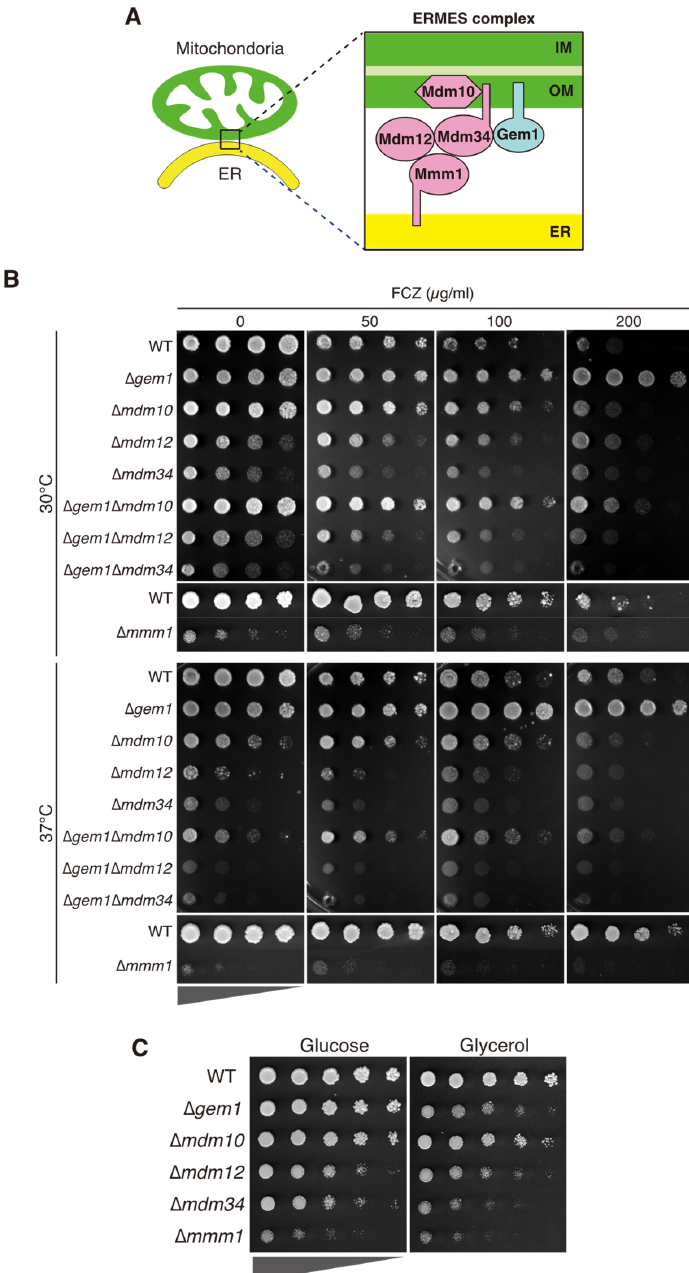
Figure 1. Resistance to azoles by deletion of GEM1 . ( A ) Schematic diagram of the ERMES complex, based on a report in S . cerevisiae . OM, outer membrane. IM, inner membrane. ( B ) Growth of strains lacking ERMES components ( ∆ mdm12 , ∆ mdm3 4, ∆ mdm10 , ∆ mmm1 , and ∆ gem1 ) in the presence or absence of fluconazole. The cells were diluted to OD 600 (optical density at 600 nm) of 0.5 in water and spotted in 4 ‐ fold serial dilutions (indicated by triangles) on agar plates of minimal SD medium containing the indicated concentration of fluconazole. All cells except for ∆ mmm1 cells were incubated for 2 days (upper panel), and ∆ mmm1 cells were incubated for 3 days at 30 °C or 37 °C. ( C ) Growth of strains lacking ERMES components on the plate containing glycerol as the carbon source. The cells were spotted in 4 ‐ fold serial dilutions on the minimum medium containing glucose or 3% glycerol and incubated for 3 days at 30 °C.